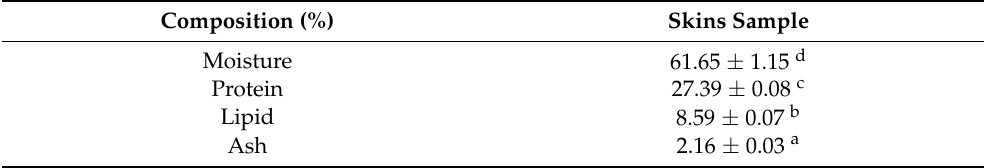
Table 1. Proximate composition of needlefish